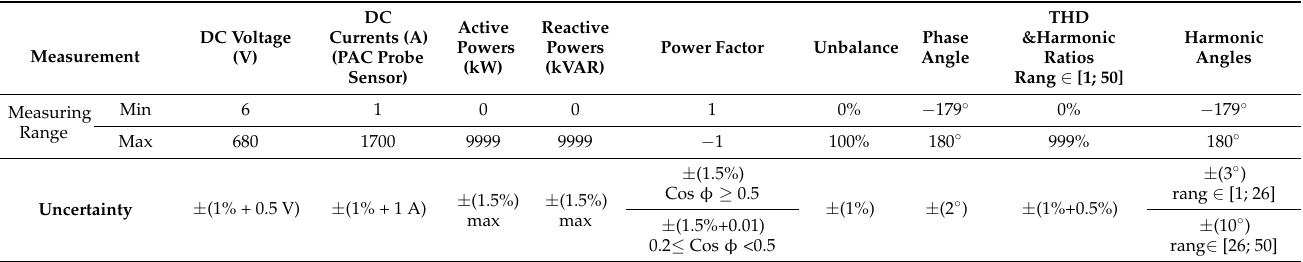
Table 4. Electrical specifications of the power quality analyzer measuring